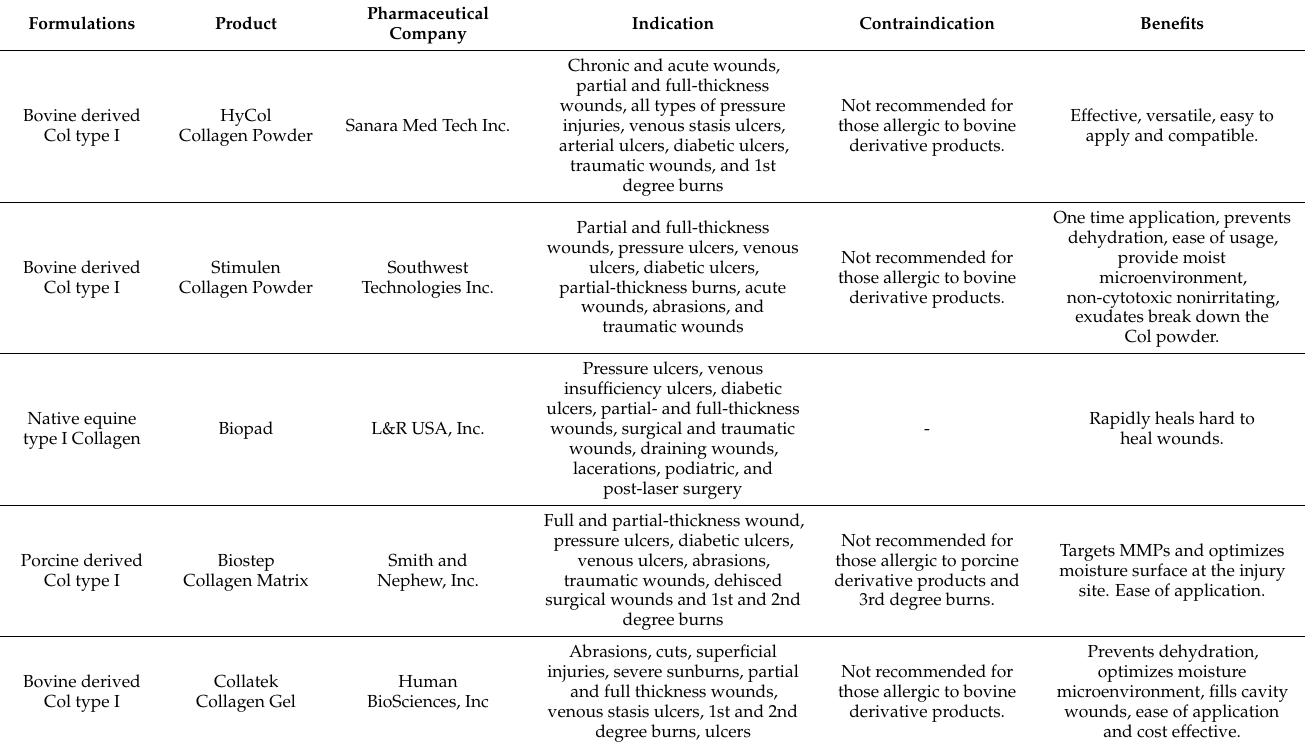
Figure 1. Mechanism of collagen matrix as drug carriers as used under the creative commons attribution 3.0 license [112]. Table 5. Current FDA approved skin healing products from native